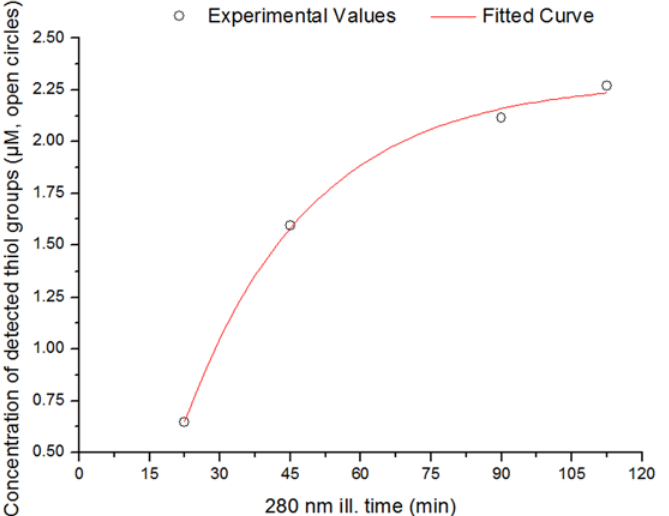
Fig 13. Increase in the concentration of detected free thiol groups (open circles) in human plasminogen UV-illumination. Detection of free thiol groups was carried out using the Ellman ’ s assay after 280 nm light continuous illumination (22.5 min, 45 min, 90 min, or 112.5 min) of human plasminogen in solution. The experimental values were fitted using an exponential function y = y 0 − A.e -R0t (fitted curve in red), where y is the concentration of thiol groups ( µ M) at the 280 nm illumination time t (h), y 0 and A are constants and R0 is the rate of thiol group formation (h -1 ). Fitted experimental parameters were: y 0 = 2.29 ± 0.07 µ M, A = 3.78 ± 0.42 µ M, R0 = 0.037 ± 0.005 min -1 . Root mean square error was